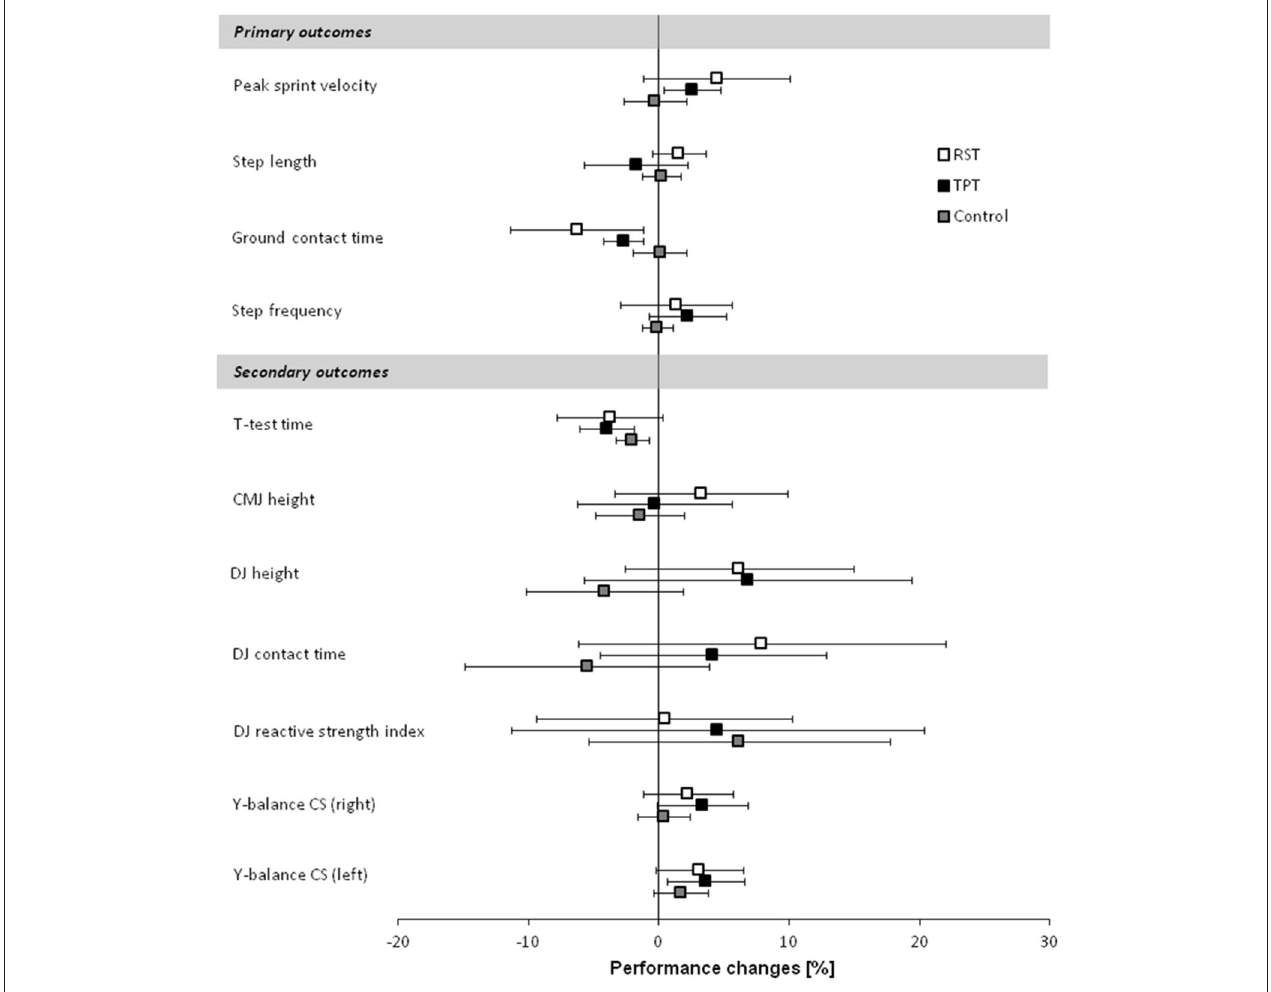
FIGURE 3 | Relative pre- to post-test changes for the resisted sprint training (RST) group, traditional power training (TPT) group, and control group. Data represent mean and 90% confidence interval. CMJ, countermovement jump; CS, composite score; DJ, drop jump; RST, resisted sprint training; TPT, traditional power training.